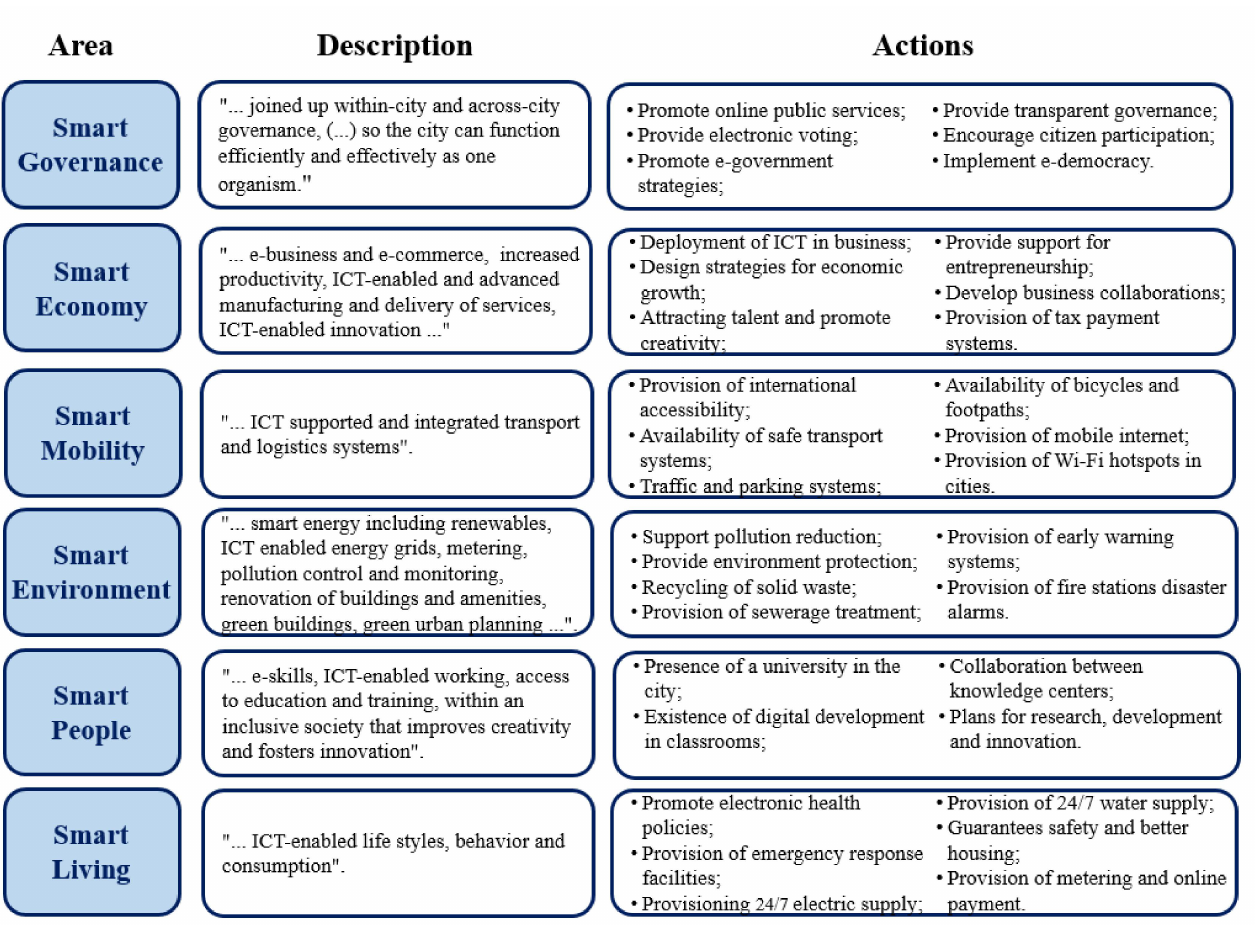
Figure 1. The Smart City Areas (source: adapted from